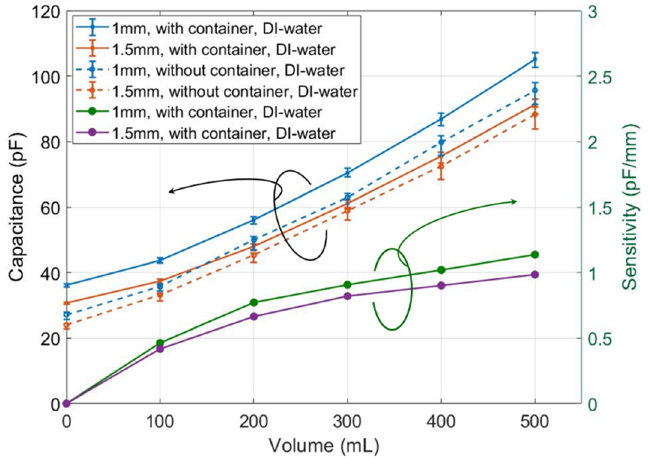
Figure 12. Capacitance measurement of sample sensors with and without container in DI water, and the related sensitivity.